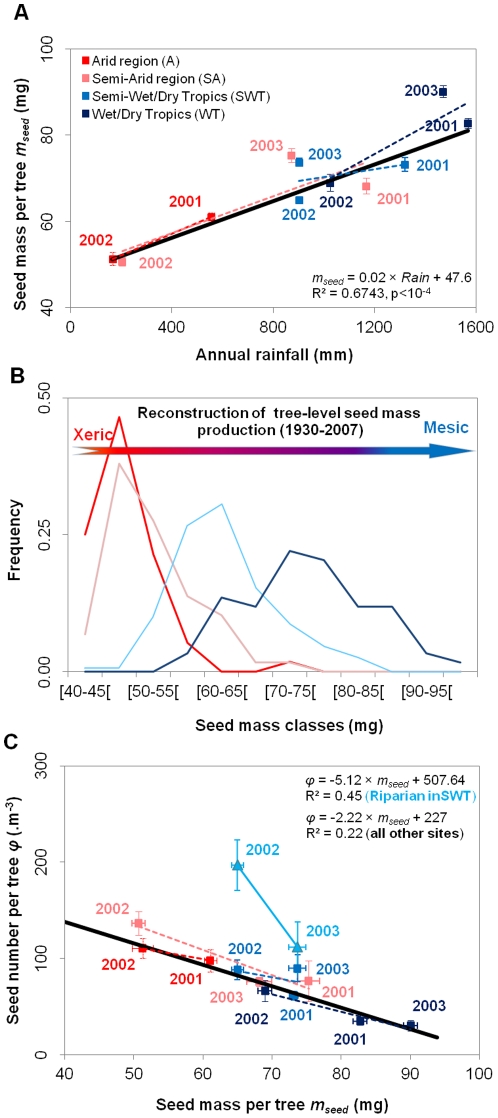
Tree-level plastic response between the mass of individual seeds and the number of seeds produced across the rainfall gradient.
A) Reversible plastic tree-level response of the seed mass-seed number trade-off to rainfall. B) Reconstruction of seed mass distribution across the rainfall gradient from 1930 to 2007, using the observed plastic response. C) The most parsimonious tree-level trade-off between seed production and seed mass across the rainfall gradient. Nomenclature - colours correspond to climate regions, as in Figure 1A. Error bars represent s.e.